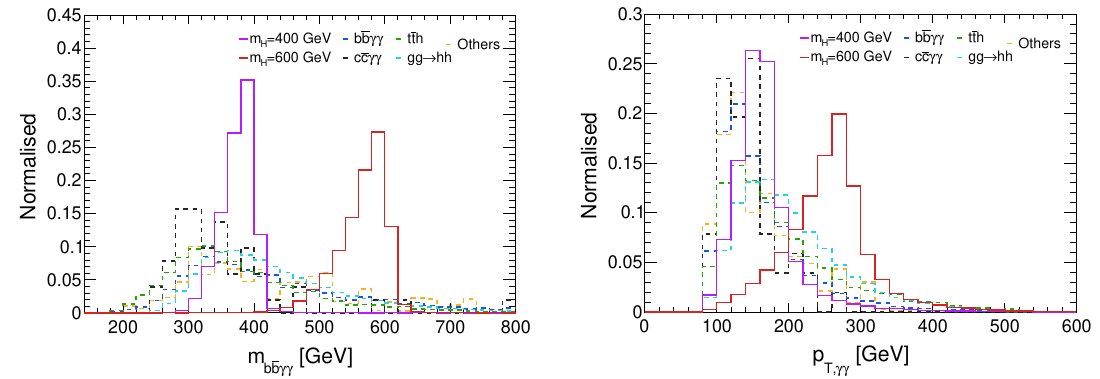
Figure 9 . The m and p T;(cid:13)(cid:13) distributions for heavy Higgs masses of m A = 400 and 600 GeV with b (cid:22) b(cid:13)(cid:13) backgrounds. Here the heavy pseudoscalar is searched for in the bb(cid:13)(cid:13) (cid:12)nal state. The distributions are shown after imposing the (cid:12)xed cuts.